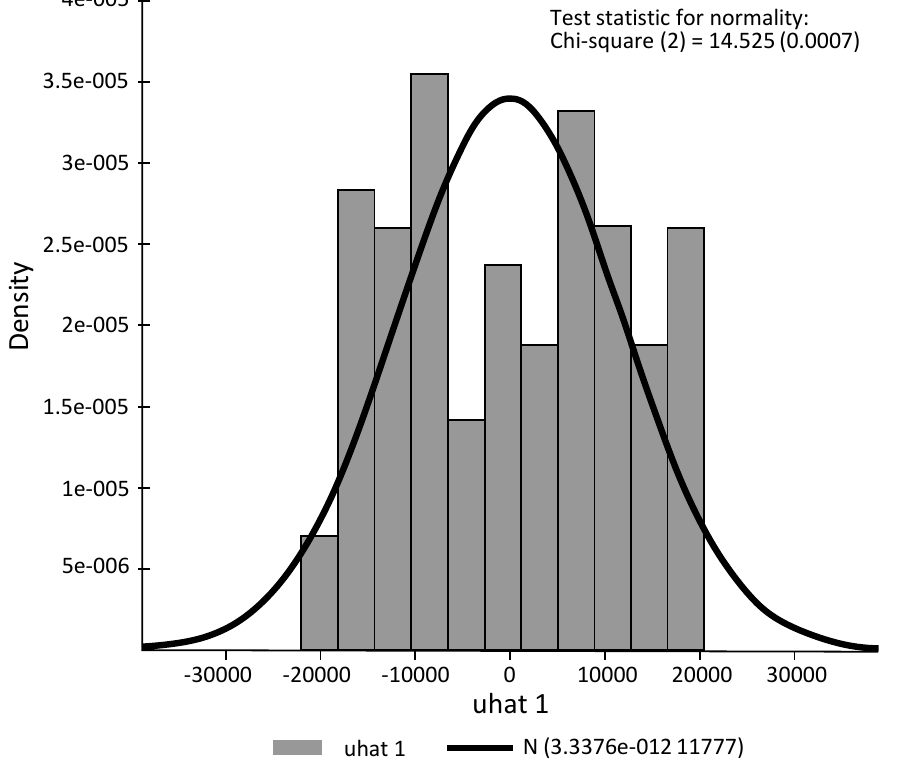
Figure 5. Distribution of ordinary least squares